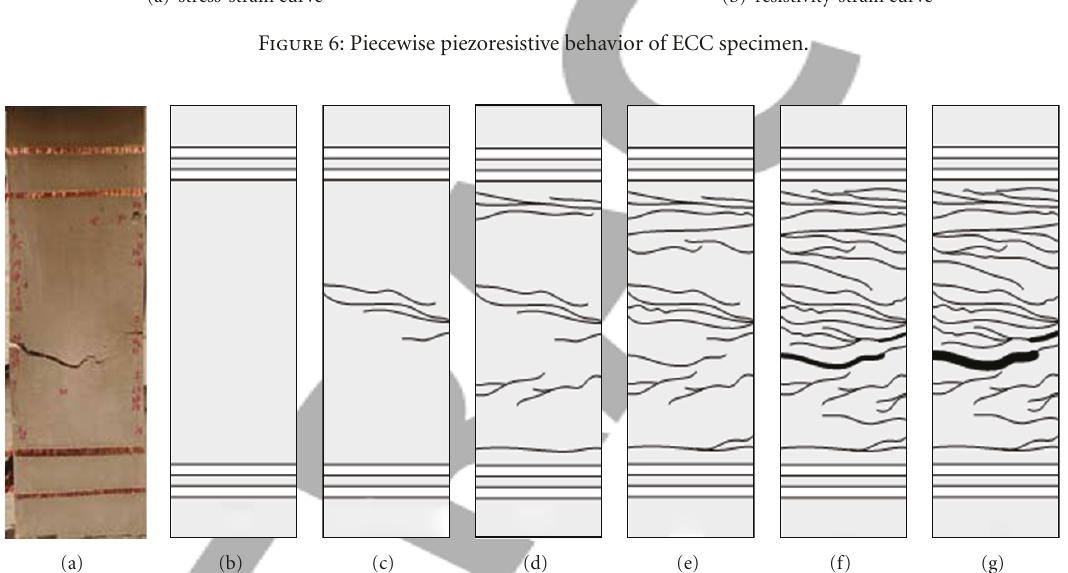
Figure 6: Piecewise piezoresistive behavior of ECC specimen.